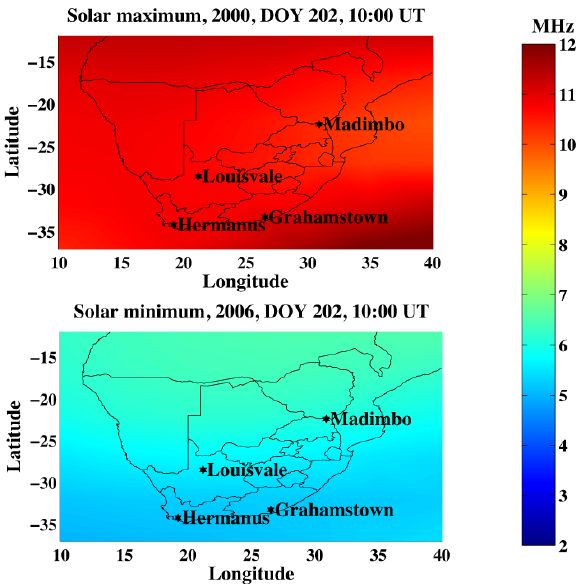
Figure 9. foF2 maps on an arbitrarily chosen DOY (202) during solar maximum (2000) and during solar minimum (2006).